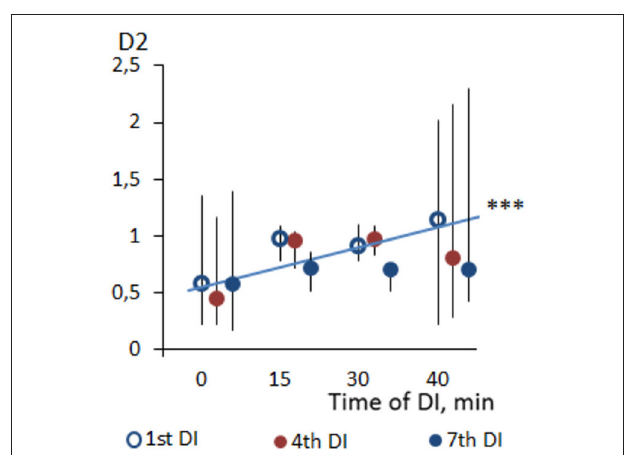
FIGURE 4 | Dynamics of correlation dimension (D2) of HRV in PD patients during repeated “dry” immersion sessions. The blue line represents the regression line of D2 within the DI session (average of three studied DI sessions). *** p < 0.001 (Friedman test).